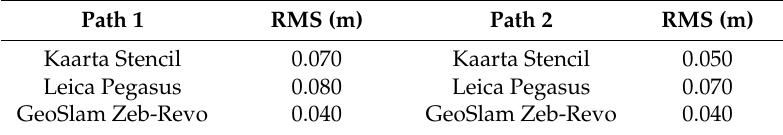
Table 2. The RMS of signed distances of IMMS datasets with respect to the ground truth.